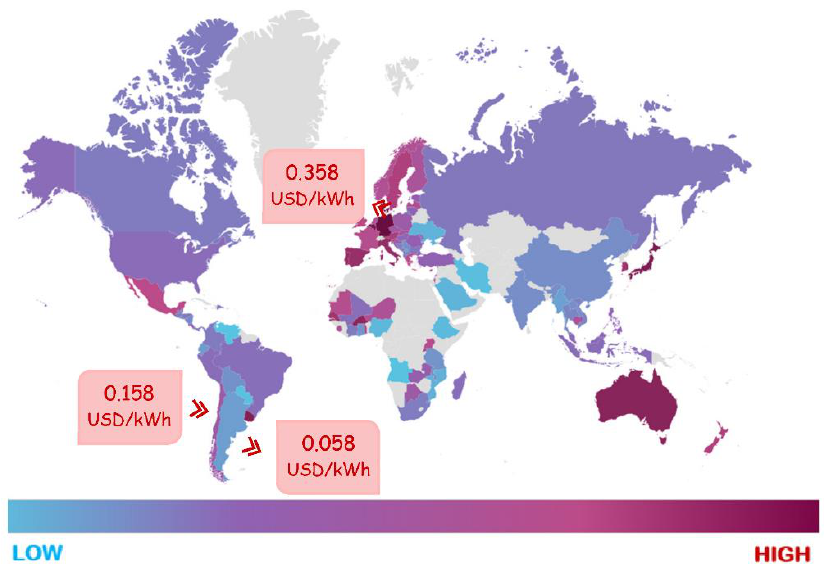
Figure 5. World map: electric tariffs for residential use (USD/kWh) [39].